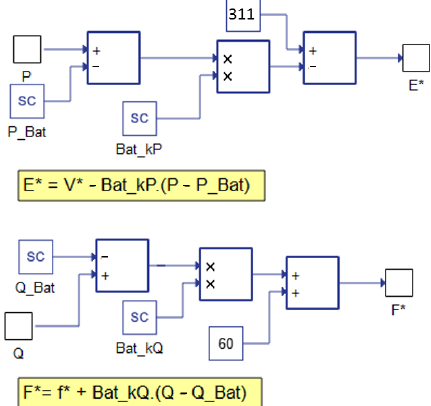
Figure 19. Droop control blocks.